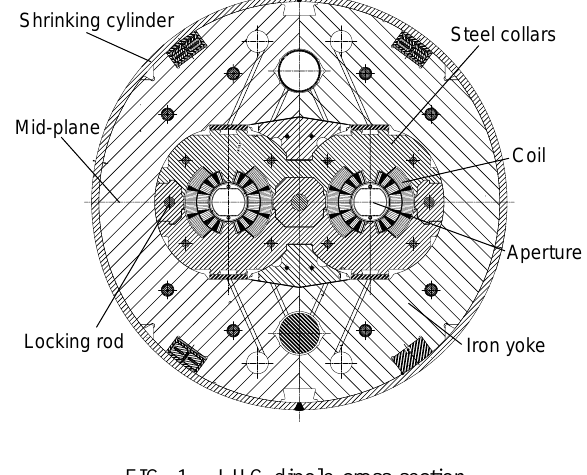
FIG. 1. LHC dipole cross section.